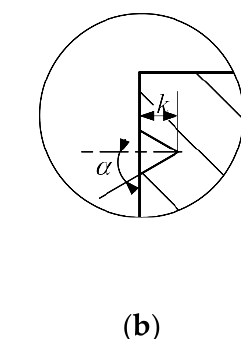
Figure 4. Schematic of main structure of the MS14101-9 bearing: ( a ) Structure of the bearing; ( b ) Structure of the V groove.